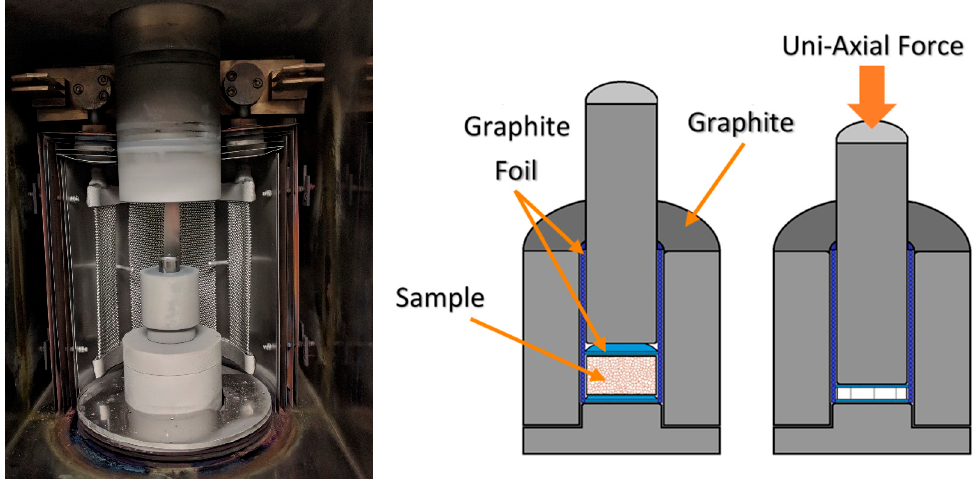
Figure 4 . Vacuum furnace and graphite die. Figure 4. Vacuum furnace and graphite